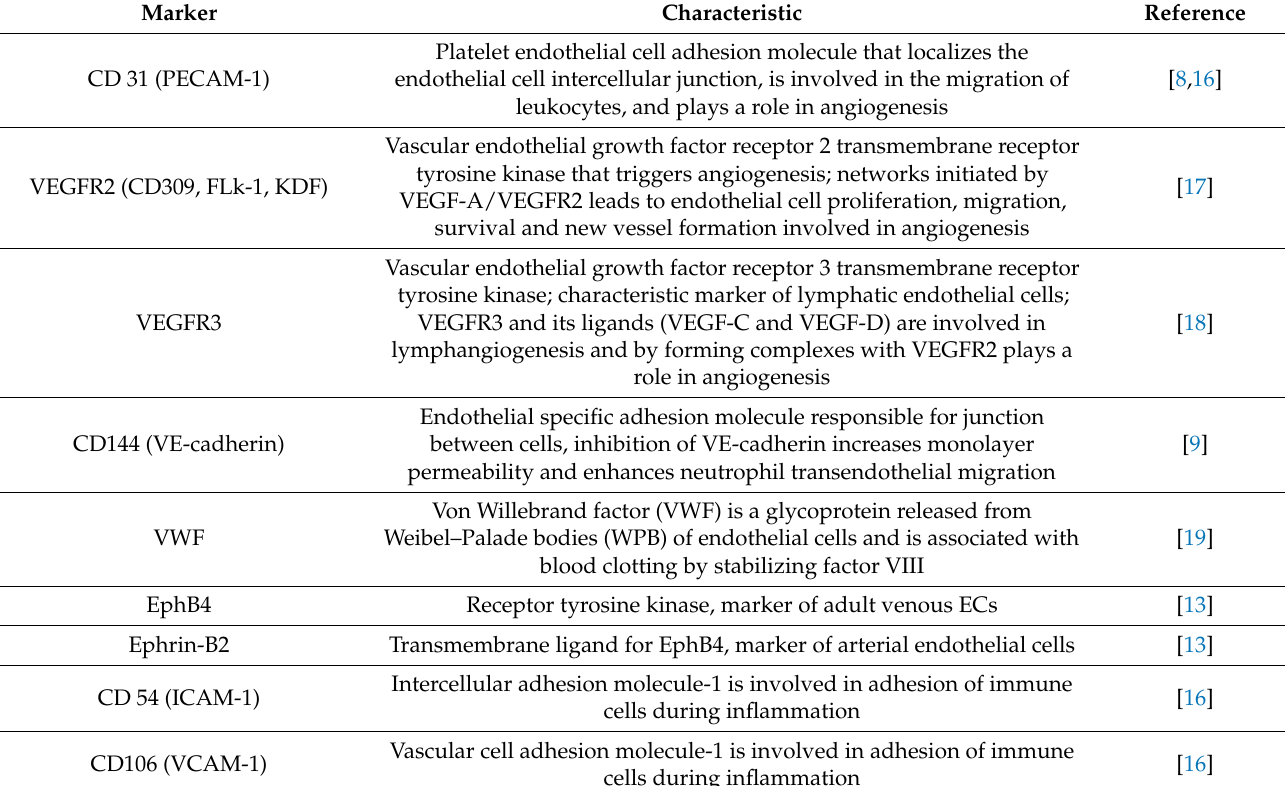
Table 1. Cellular markers for the phenotyping of endothelial